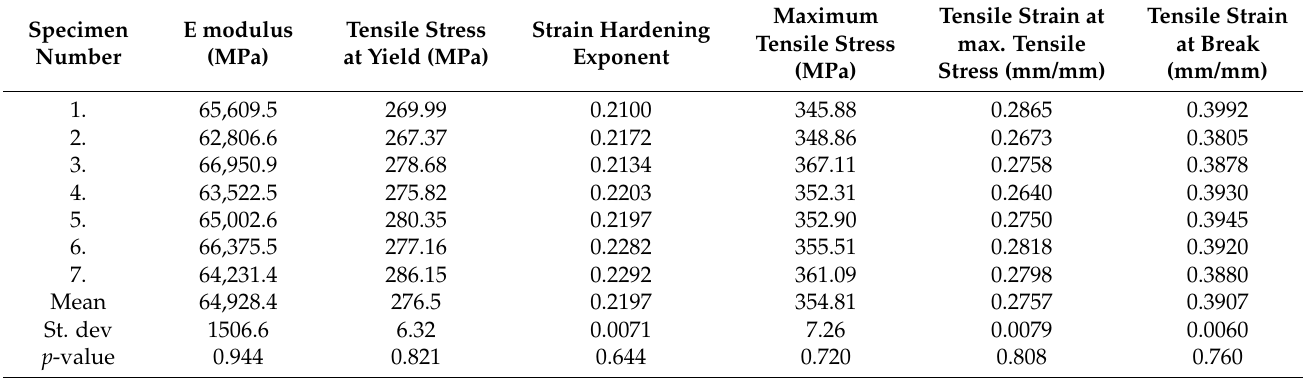
Table 3. Results of uniaxial tensile test for unwelded specimens collected on rolling direction.